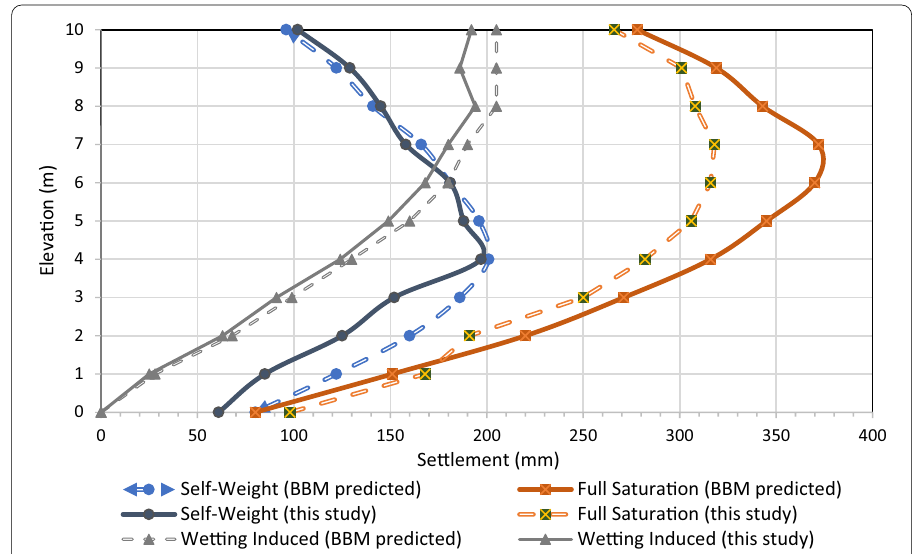
Fig. 7 Comparison of settlements in different stages in three cases of self-weight loading, full saturation and